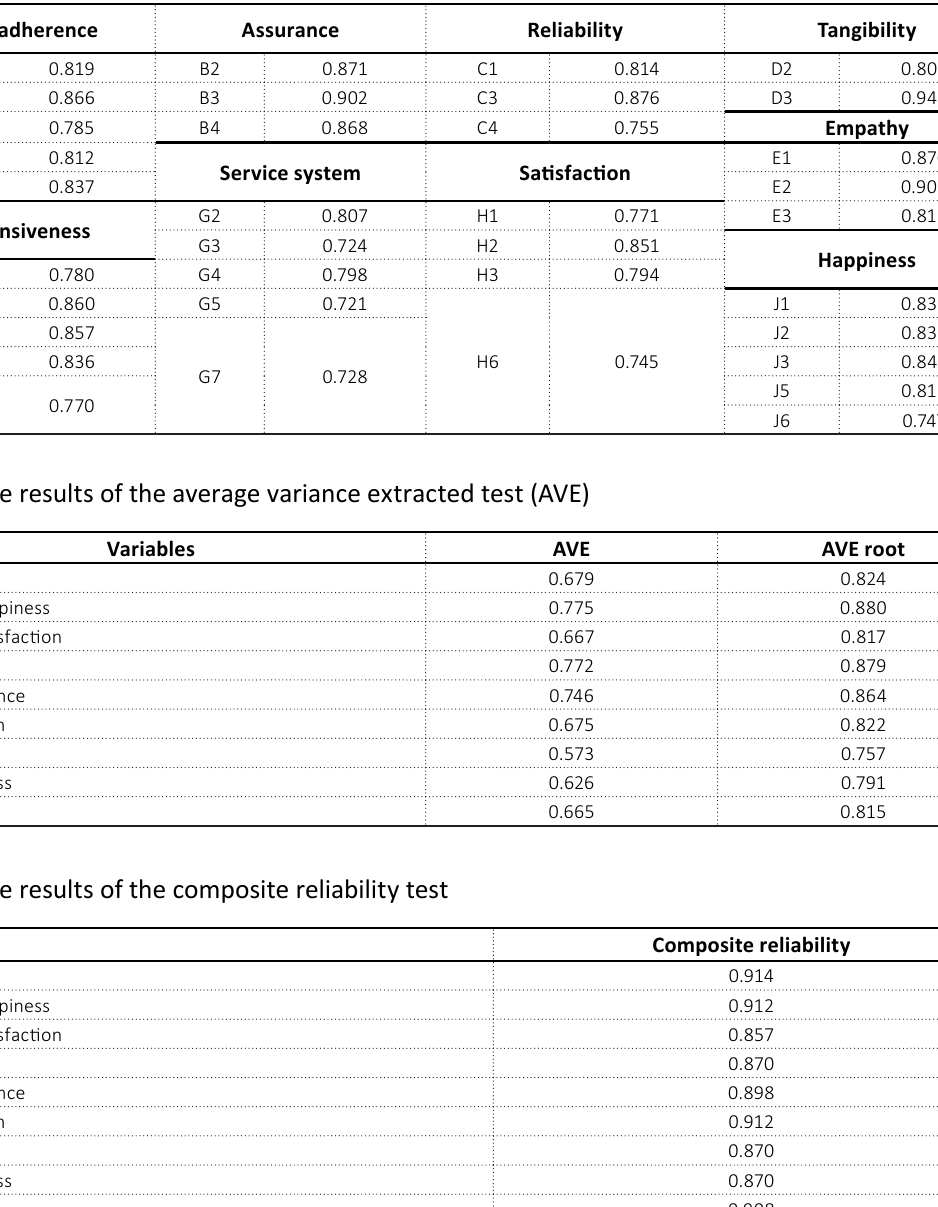
Table 2. The results of the second convergent validity test